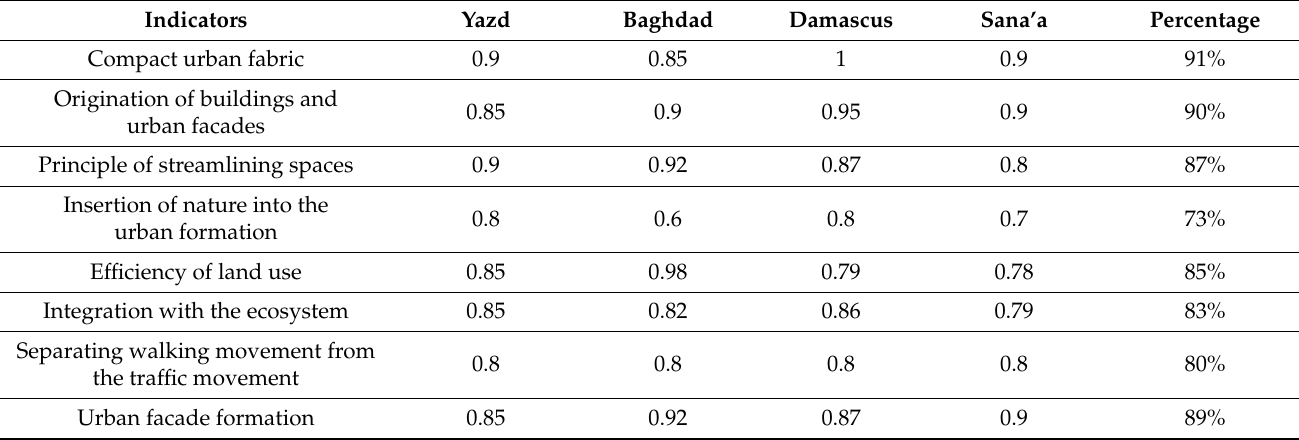
Table 4. Comparison of indicator values for the four study cities and their percentages of